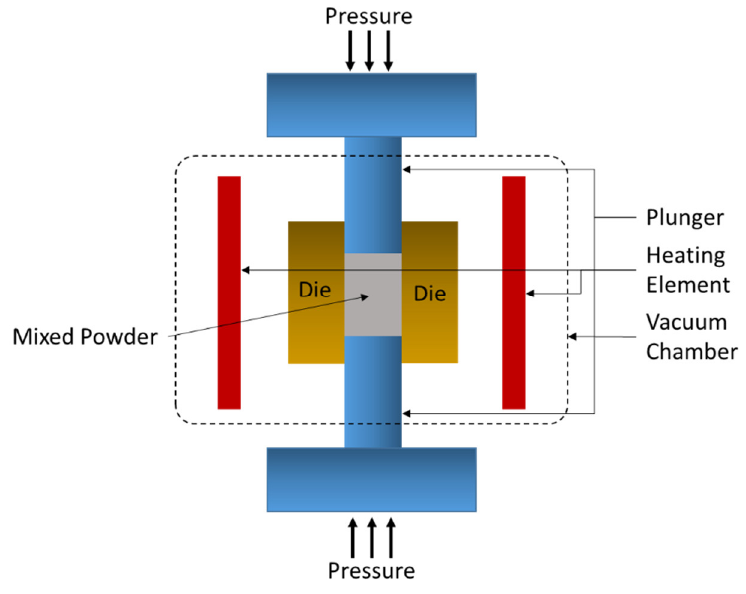
Figure 11. Schematic setup of hot-press sintering (HPS).